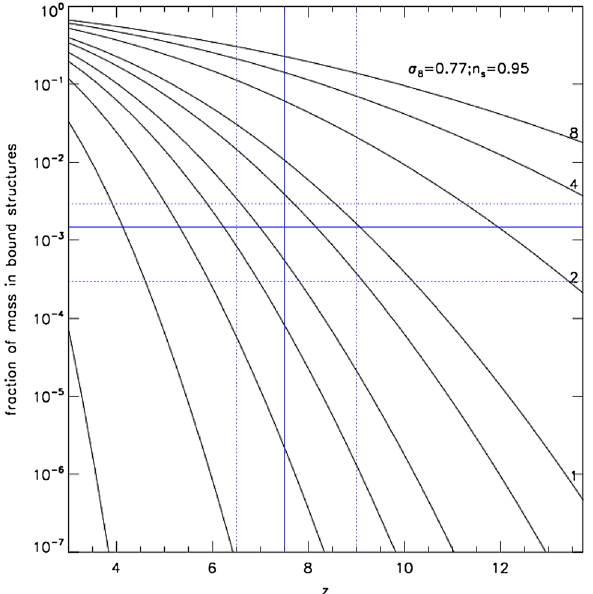
Fig. 38 The fraction of mass in bound structures as a function of redshift, normalized to a halo of Milky Way’s mass at redshift z = 0. Marked are different masses of thermal-relic WDM particles in keV (black solid lines). Notice that the differences between different WDM models increases towards higher redshift